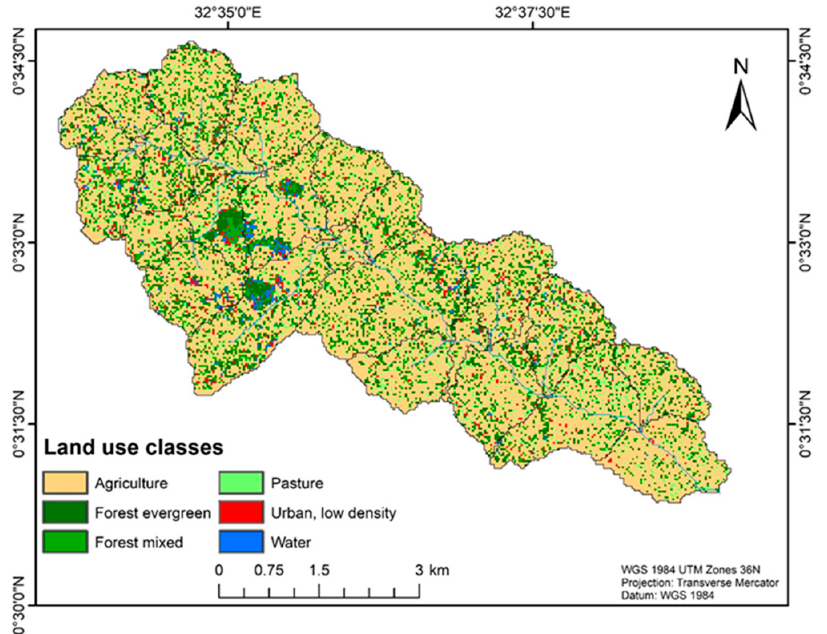
Figure 2. Land use/Land cover (LULC) distribution in the catchment, modified after [31]. Figure 2. Land use / Land cover (LULC) distribution in the catchment, modified after